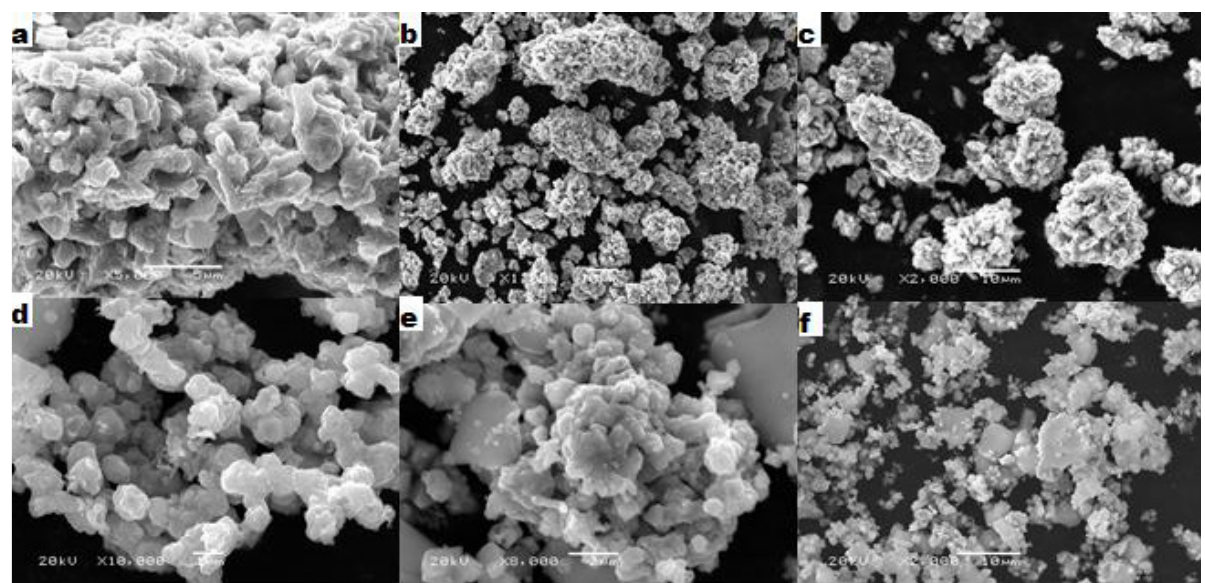
Figure 2: SEM images of the product prepared by co-precipitation method: (a-c) Co3O4 prepared sample before calcinations, (d-f) Co3O4 after